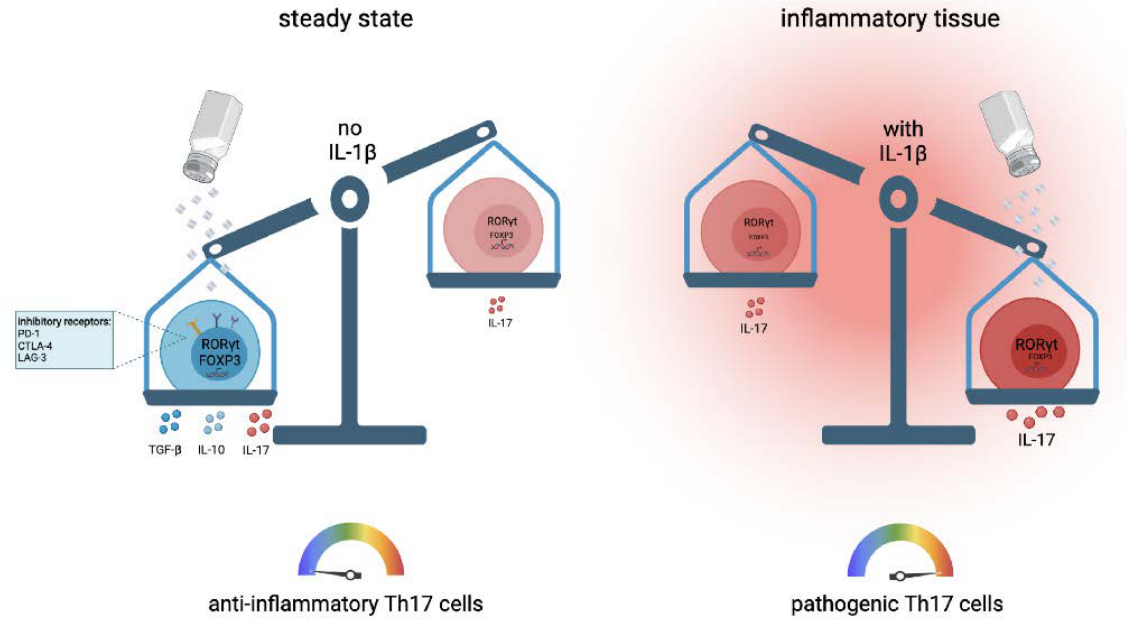
Figure 2. Sodium chloride promotes the anti-inflammatory Th17 cell identity in steady-state conditions but can also enforce Th17 cell pathogenicity in IL-1 β enriched